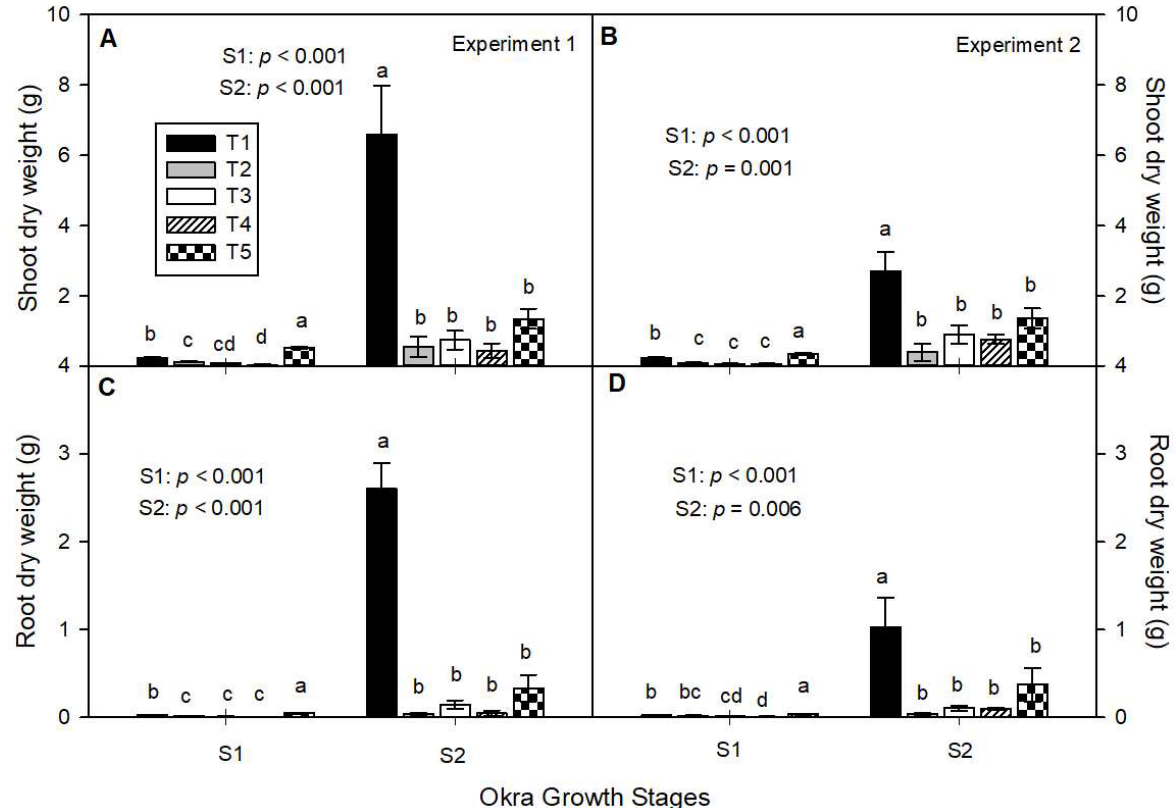
Figure 3. Effect of non-composted Bombax ceiba (red cotton tree) sawdust mixtures on Abelmoschus esculentus L. (okra). The dry weight of shoot (g) ( A , B ), and dry weight of root (g) ( C , D ), at two plant growth stages S 1 (30 days after sowing) and S 2 (110 days after sowing) in two independent experiments. All treatments (T 1 , T 2 , T 3 , T 4 , T 5 ) were the same as described in Figure 1. Different letters display significant differences between treatment mean values at the top of the vertical bars, as determined by the least significant difference test (LSD) at p < 0.05. Differences between treatments were very significant, as evidenced by the p < 0.001. The error bars show the standard error ( n = 4). The germination percentage of okra seeds did not differ significantly between any of the treatments in exp-1 and exp-2 (Figure 4A,B). The relative water content of the leaf (LRWC) was not significantly different between T 5 and T 1 in both exp-1 and exp-2. The lowest LRWC was noted in T 4 both in exp-1 and exp-2 (Figure 4C,D). The membrane stability index (MSI) was affected significantly in both soil-based and soilless treatments (Figure 4E,F). Electrolyte leakage was measured to assess the permeability of the mem- branes. The quantity of electrolyte leakage was largest in T 1 (MSI mean value: 26.18%) in exp-1. The minimum MSI was recorded in both experiments in T 3 (MSI mean value: 9.85% in exp-1 and mean value: 10.15% in exp-2) (Figure 4E,F). The statistical analysis showed a significant response of okra for the average number of days taken to produce the first flower